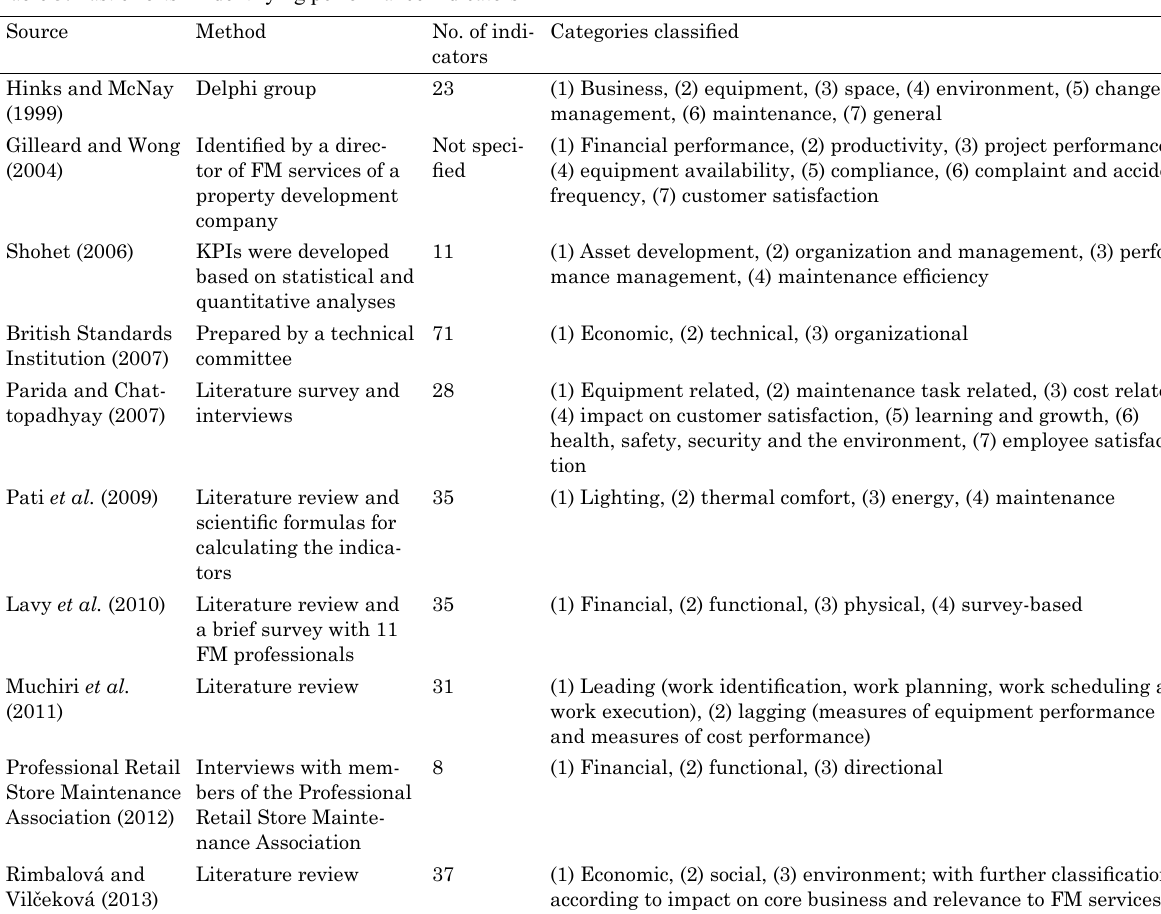
Table 3. Past efforts in identifying performance